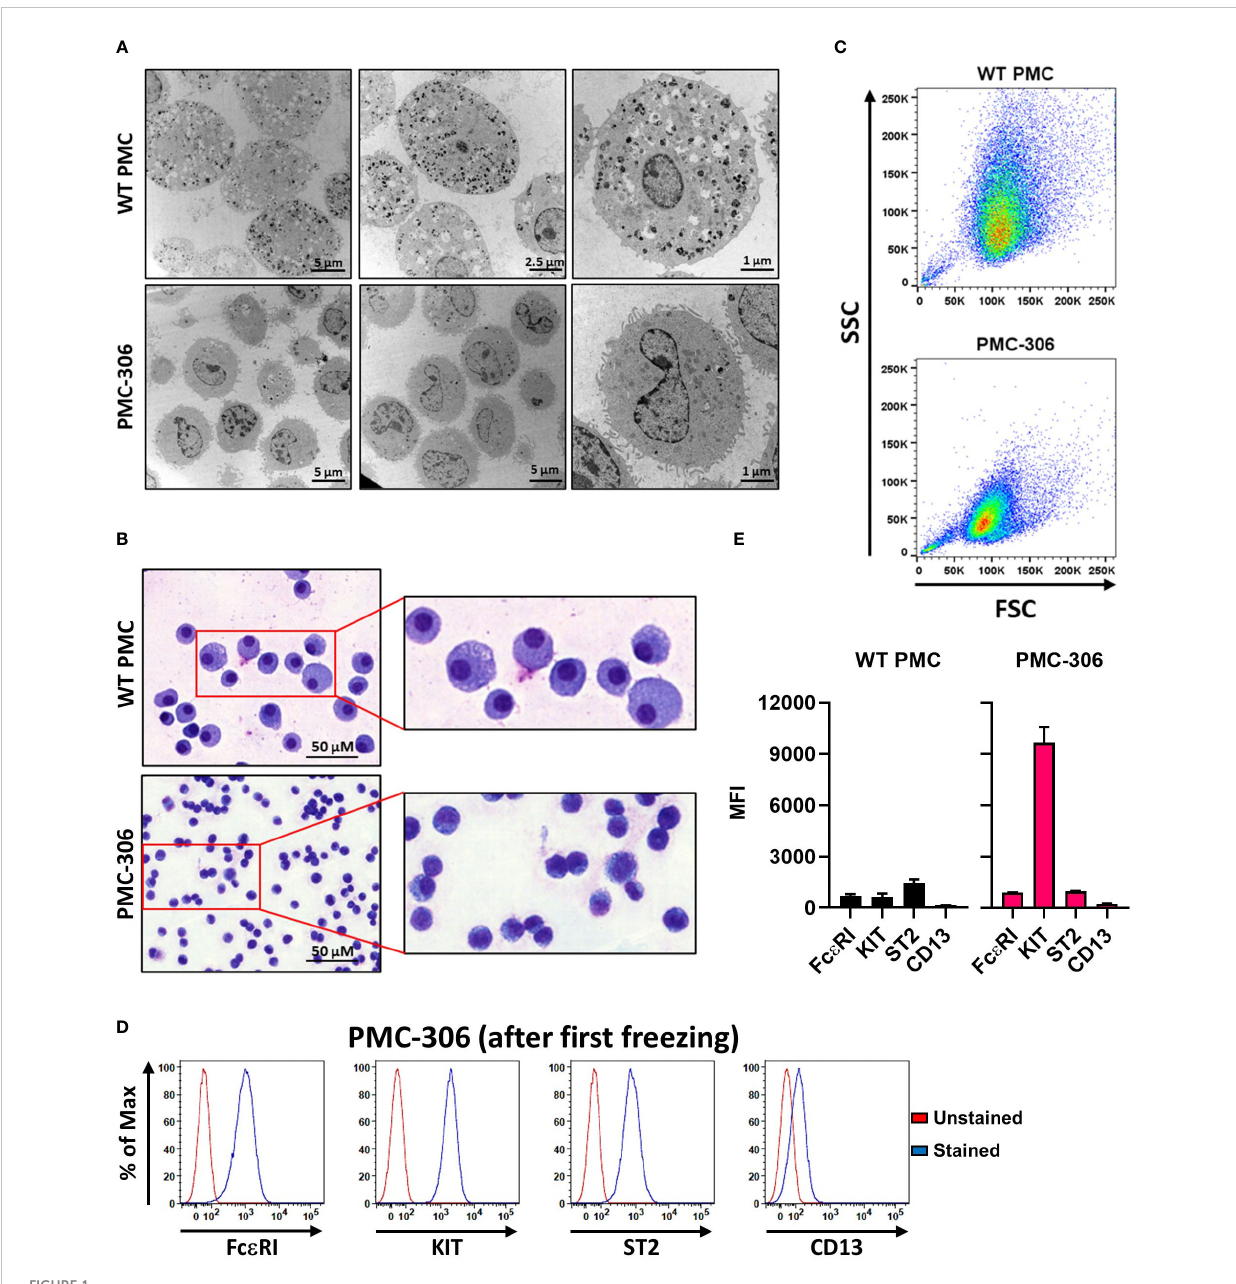
FIGURE 1 Phenotypic characterization of PMC-306 cells reveals morphological differences to primary WT PMCs. (A) Representative electron micrographs of glutaraldehyde- fi xed and agarose embedded primary WT PMCs and PMC-306 cells. (B) Representative microscopy images of fi xed MGG-stained primary WT PMCs and PMC-306 cells. (C) Representative FACS analysis of size and granularity of primary WT PMCs in comparison to PMC-306. Forward/side scatter intensities of 30,000 cells were recorded with the same settings to show differences between the two cell types (n=3). (D) Representative FACS histograms showing surface localisation of FceRI, KIT, ST2 and CD13 in PMC-306 cells after freeze-thaw in relation to an unstained control. (n=3) (E) FACS analysis of the MC surface markers Fc e RI, KIT (CD117), ST2 and CD13. Geometric mean fl uorescence intensities (MFI) are plotted for each surface marker (n=4). Data are shown as mean +